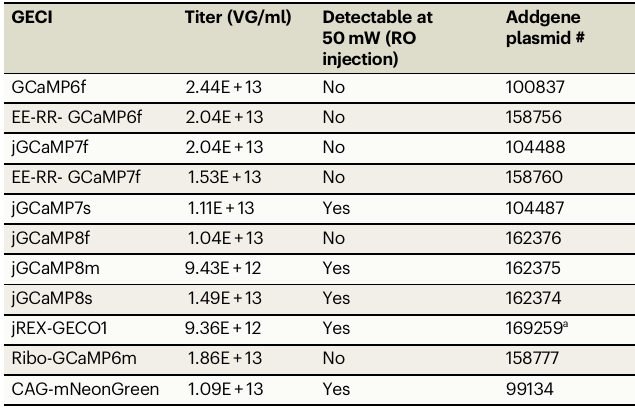
Table 1 | Overview of initial GECI screening with virus titer and Addgene reference